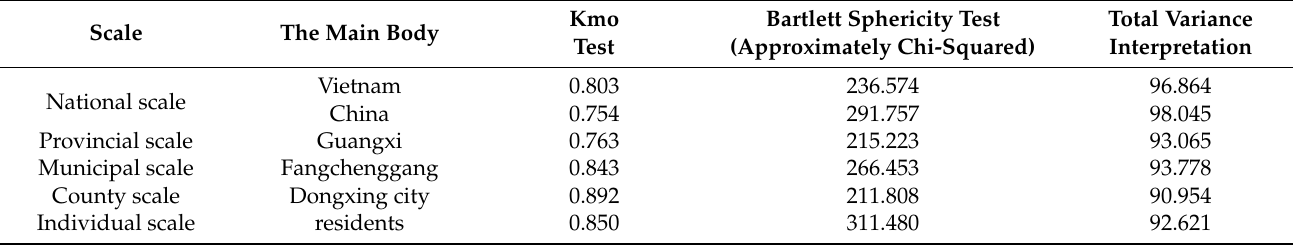
Table 4. Main component table of